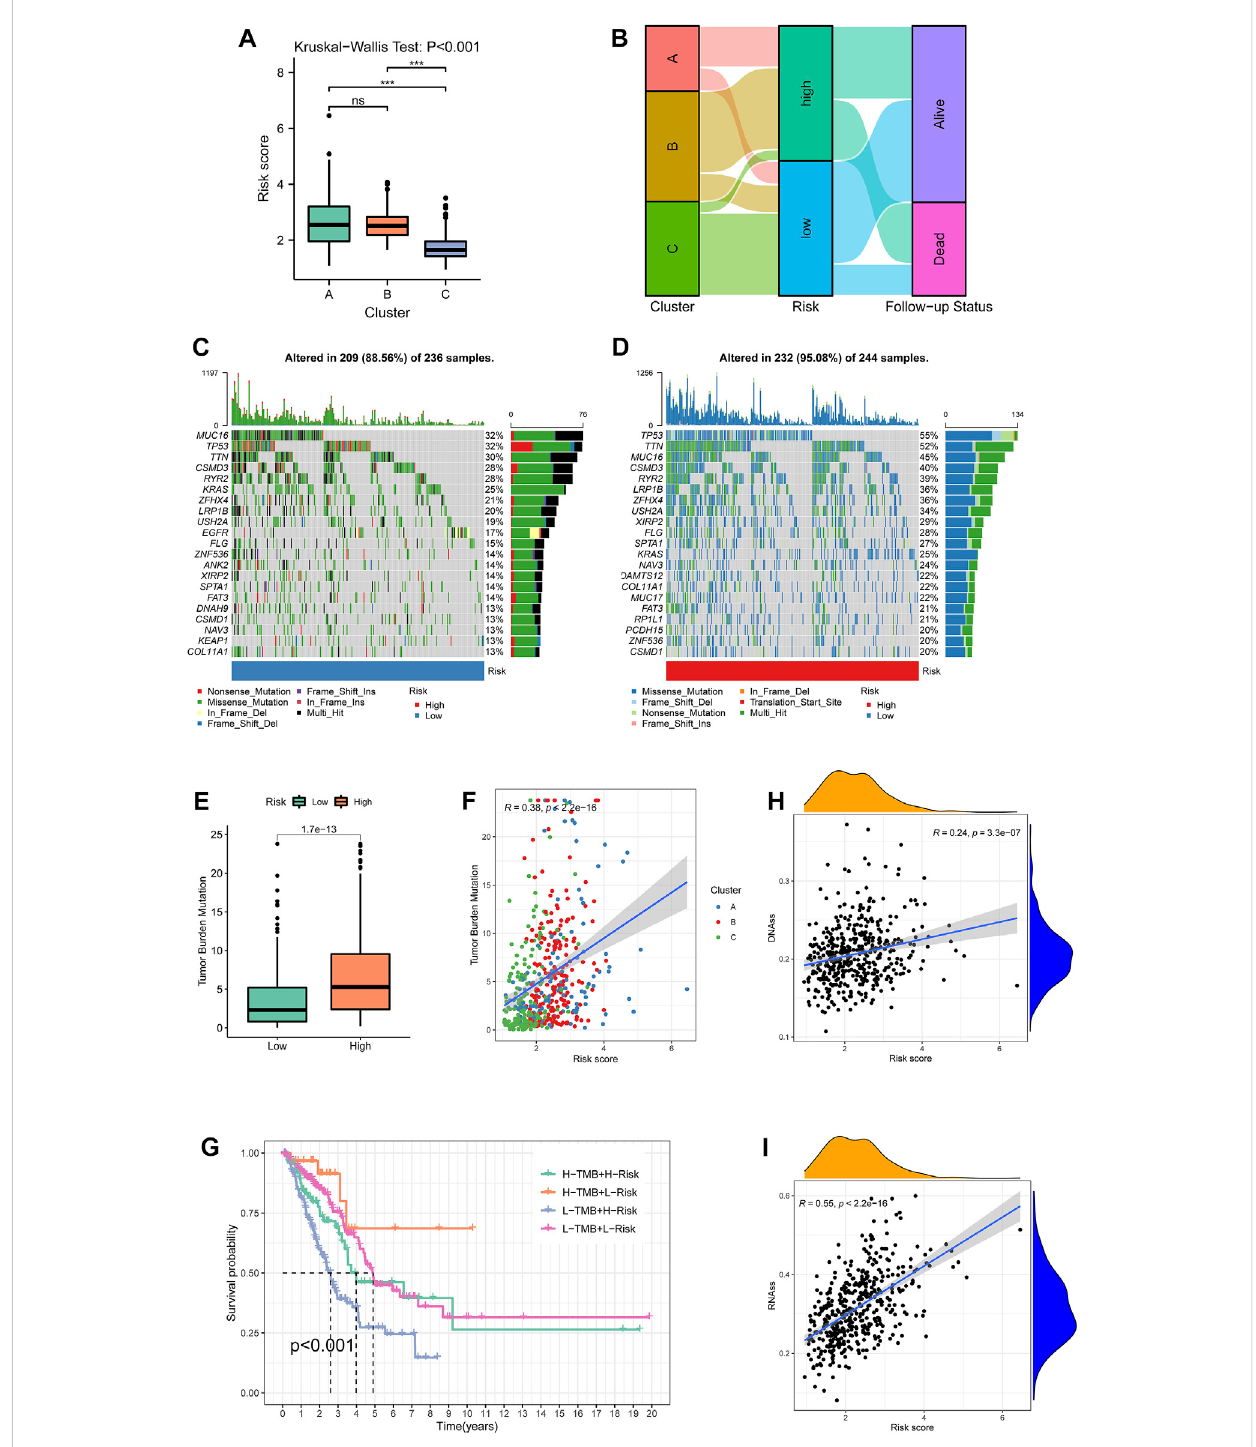
FIGURE 8 Cluster-riskandmutation-riskpro fi les. (A) VariationsamongthethreeclusteringsubtypesrevealedbytheKruskal – Wallistest. (B) Analluvialdiagram illustratedthedistributions among clusters, riskgroups, andvitalstatus. (C – D) The top 20mutatedgenesinthelow- and high-riskgroups. Theupper bar plot showed the total mutation frequency of each sample. The number on the right indicated the mutation frequency in each gene. The right bar plot showed the proportion of each variant type. The stacked stripe below showed risk subtypes, blue for low risk and red for high risk. (E) TMB differences between the low- and high-risk groups. (F) The correlation of TMB and risk scores. Points with three colors represented different clustering subtypes. (G) Survival differences among four TMB-risk strati fi cations. (H, I) Correlation between the risk score and tumor purity estimated by RNA-seq and DNA methylation. TMB: tumor mutational